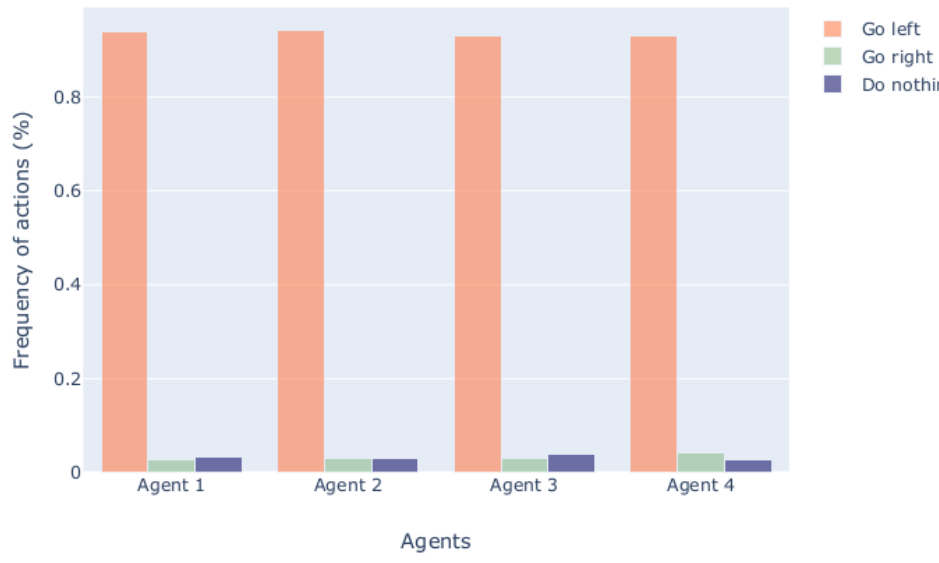
Figure 5. Frequency of actions for last 200 episodes of compound conflict with 4